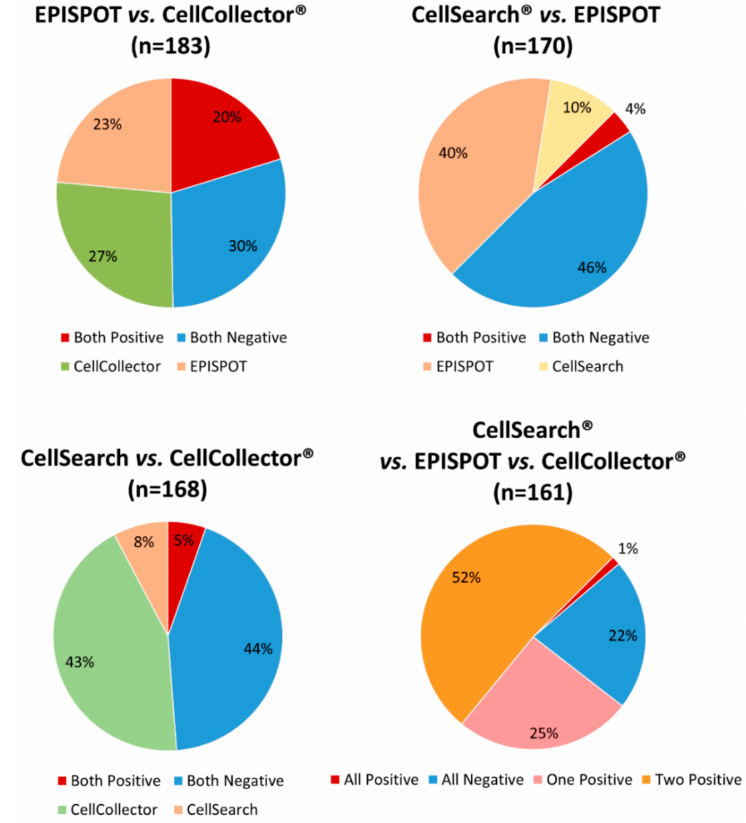
Figure 5. Concordance between two or three CTC detection assays. The chart shows the number of concordant positive (red) or negative (blue) results for the same sample obtained with two or three detection assays, as